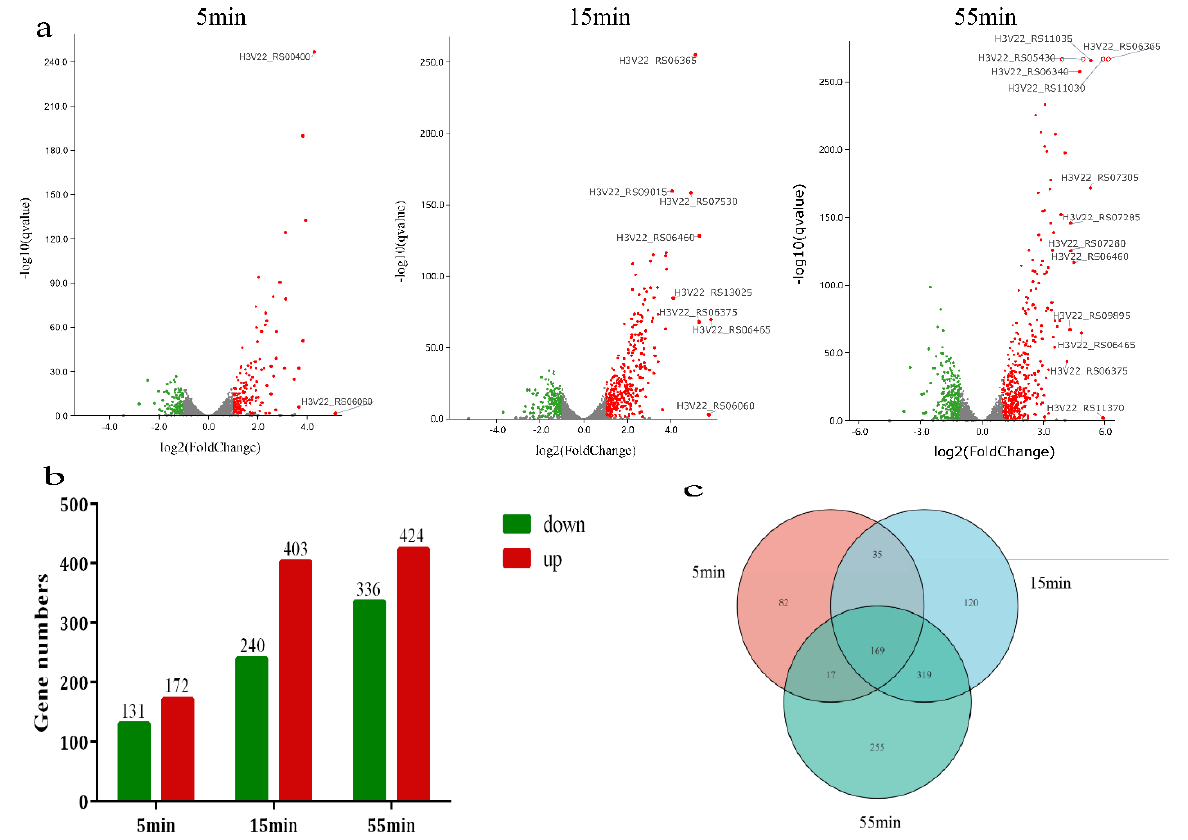
Figure 3. The effect of phage SA1 infection on host S. lentus transcription. ( a ) Volcano plots of the S. lentus transcriptome following phage infection compared with the uninfected control. Each dot represents an ORF, with upregulated genes shown in red and downregulated genes in green. ( b ) Number and distribution of DEGs at different infection stages. ( c ) The Venn diagram shows the intersection of the number of DEGs at each timepoint.